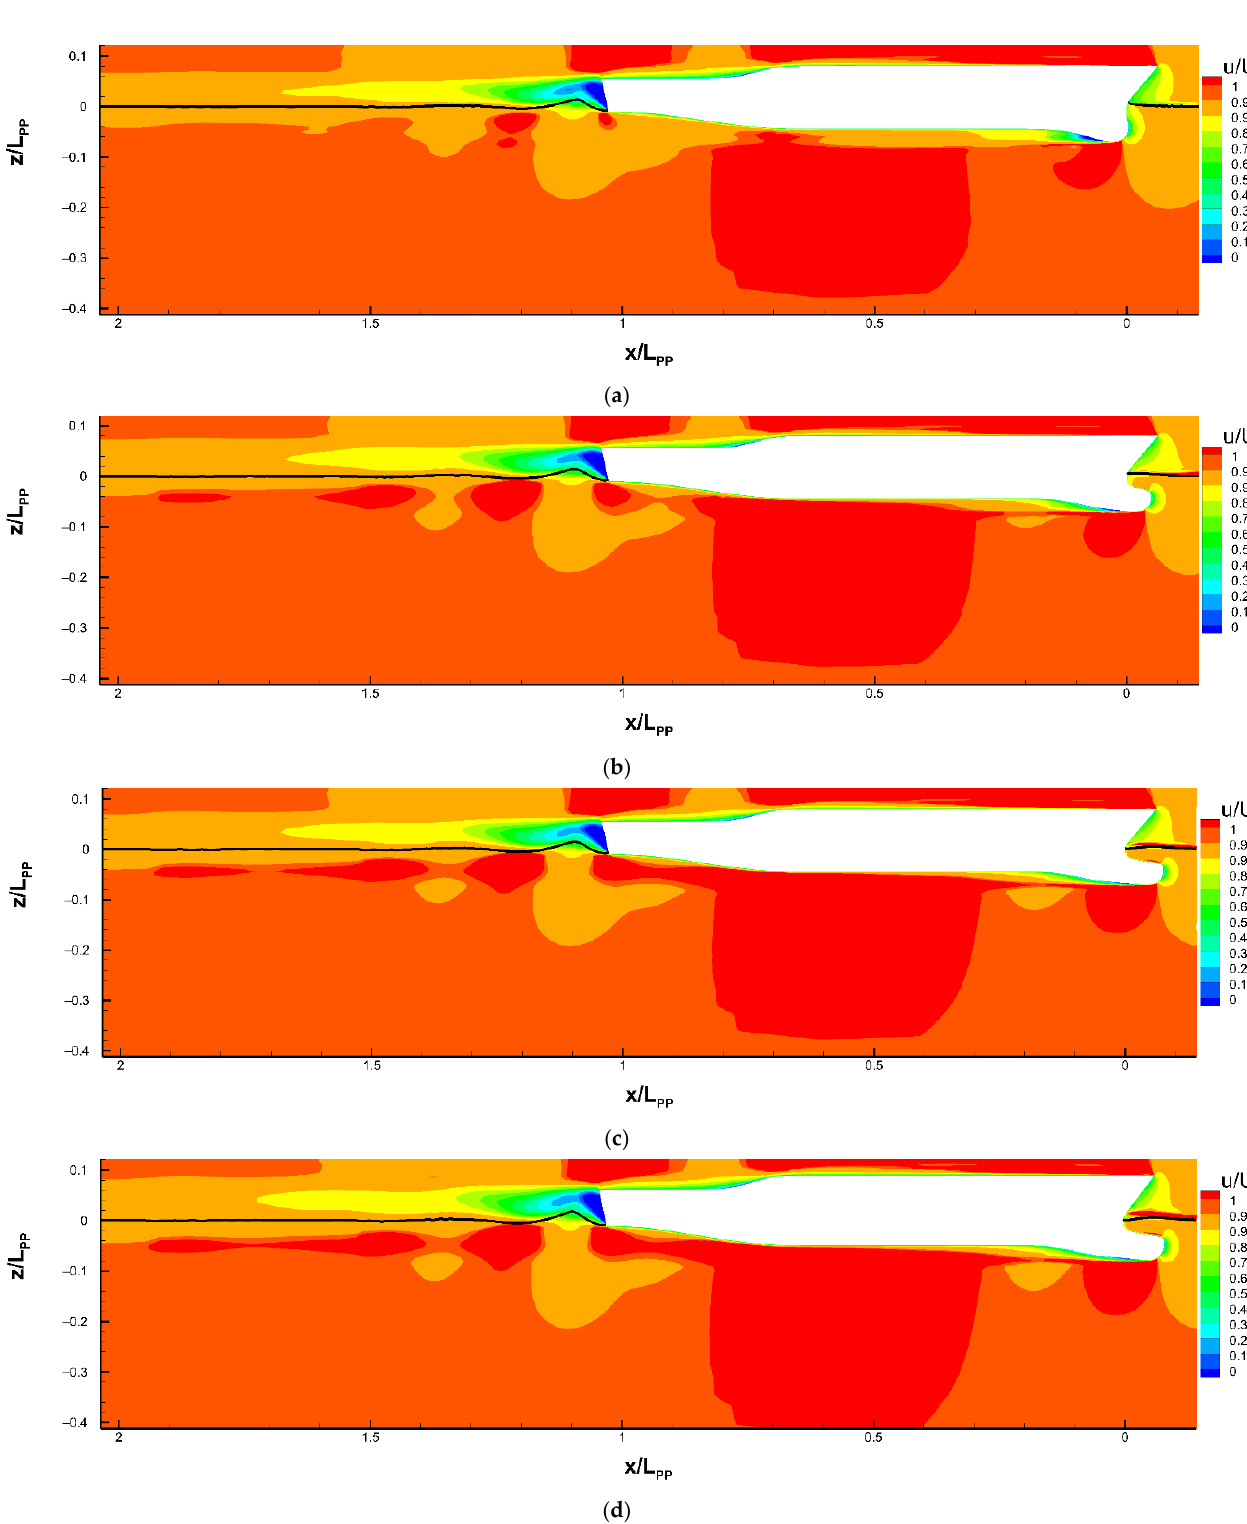
Figure 11. Axial velocity distribution around the ship ’s hull (on y = 0 plane): ( a ) F0; ( b ) F0.14; ( c ) F0.225; ( d ) F0.24. U = U 0 . Compared to F0, the u/U 0 > 1 area of F0.14, F0.225, and F0.24 is larger under the ship. Especially for F0.225 and F0.24, the u/U 0 > 1 area is continuous under the sonar dome and through the whole ship’s bottom. In the ship’s wake, the u/U 0 > 1 area of F0.14, F0.225, and F0.24 develops very long downstream up to around x/L pp = 1.9. F0.14’s area is